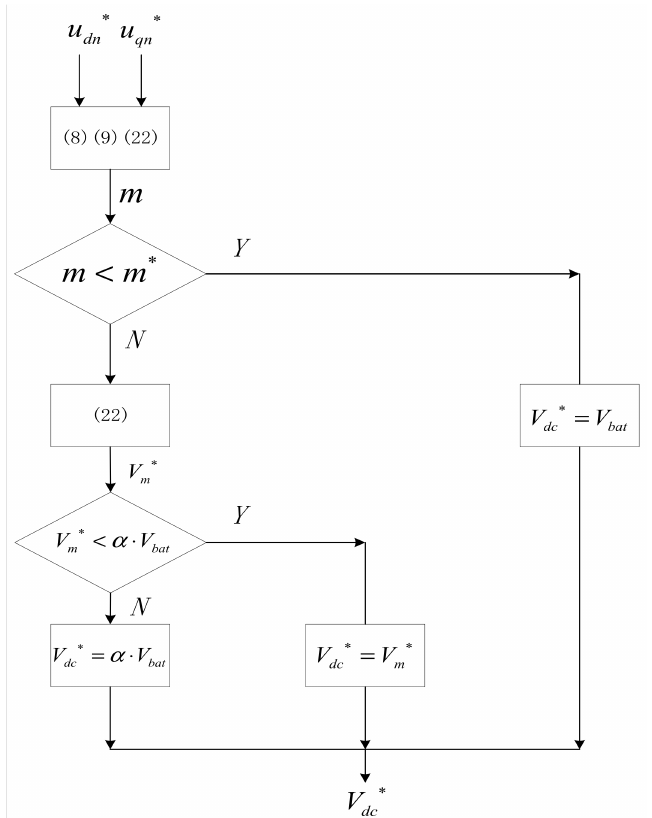
Figure 4. Control flow diagram of the fixed SVPWM modulation